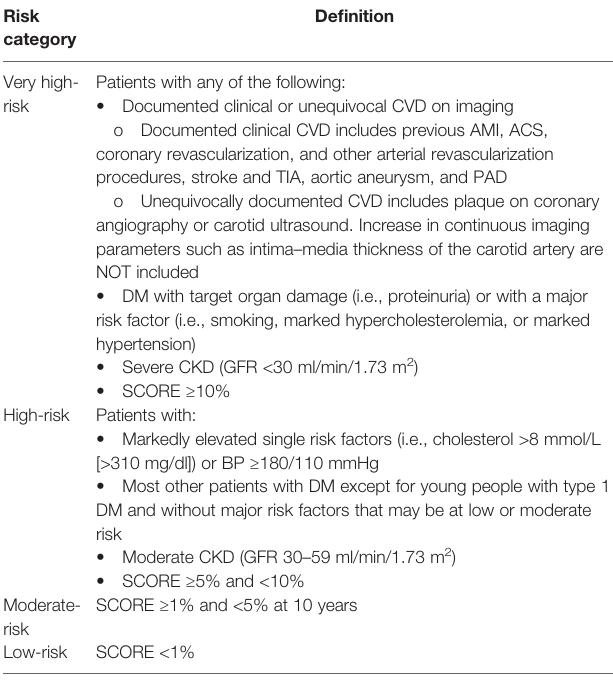
TABLE 2 | Cardiovascular risk categories strati fi ed according to the European Society of Cardiology Guidelines (25).